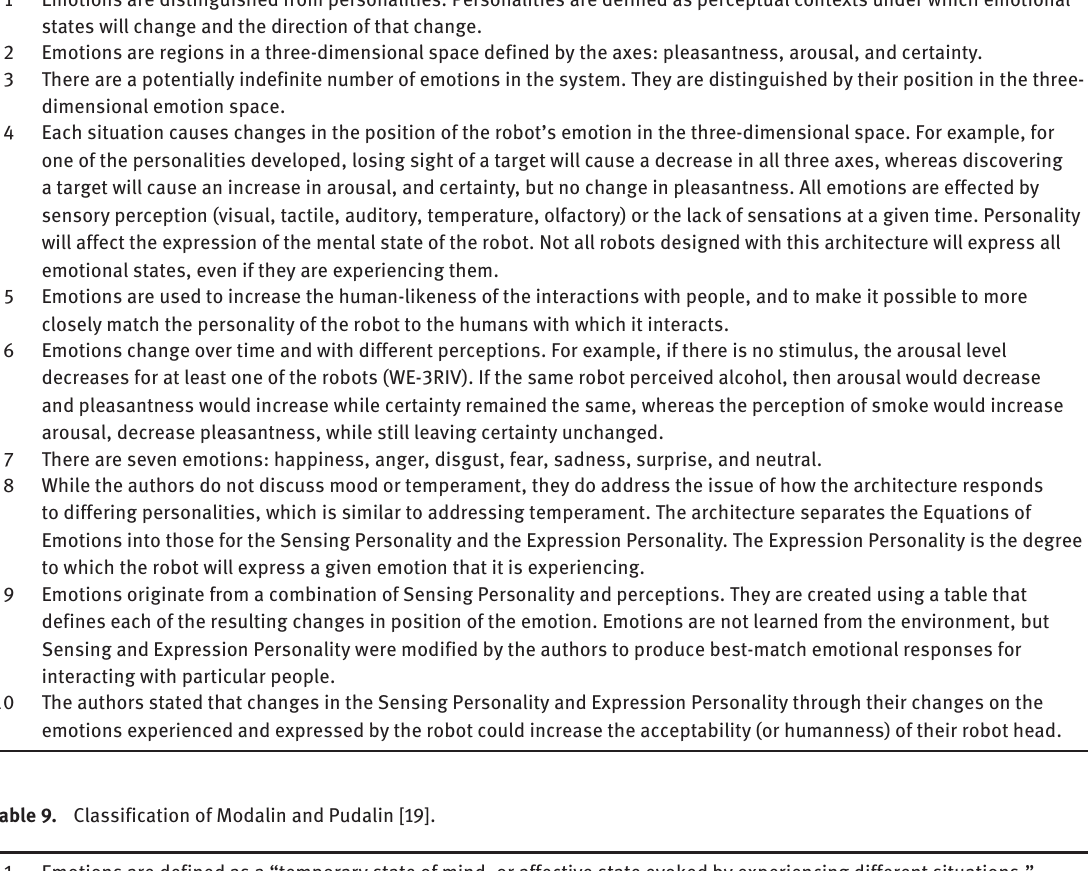
Table 8. Classification of WE-3RIV